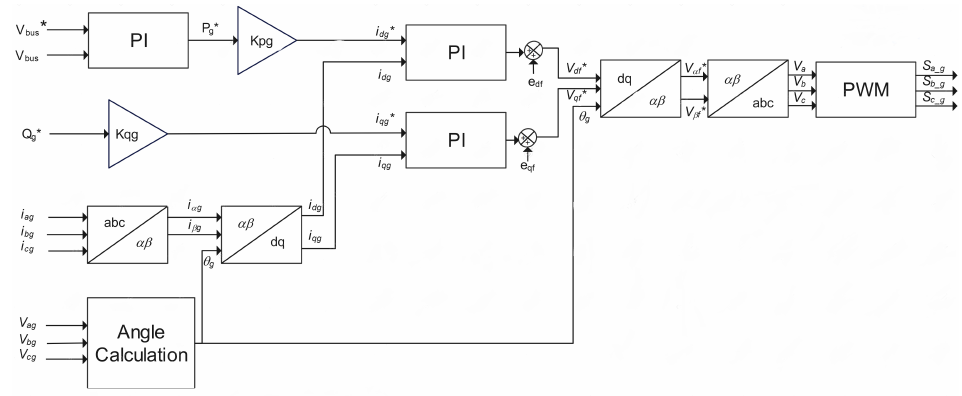
Figure 5. Vector control of grid-side converter.